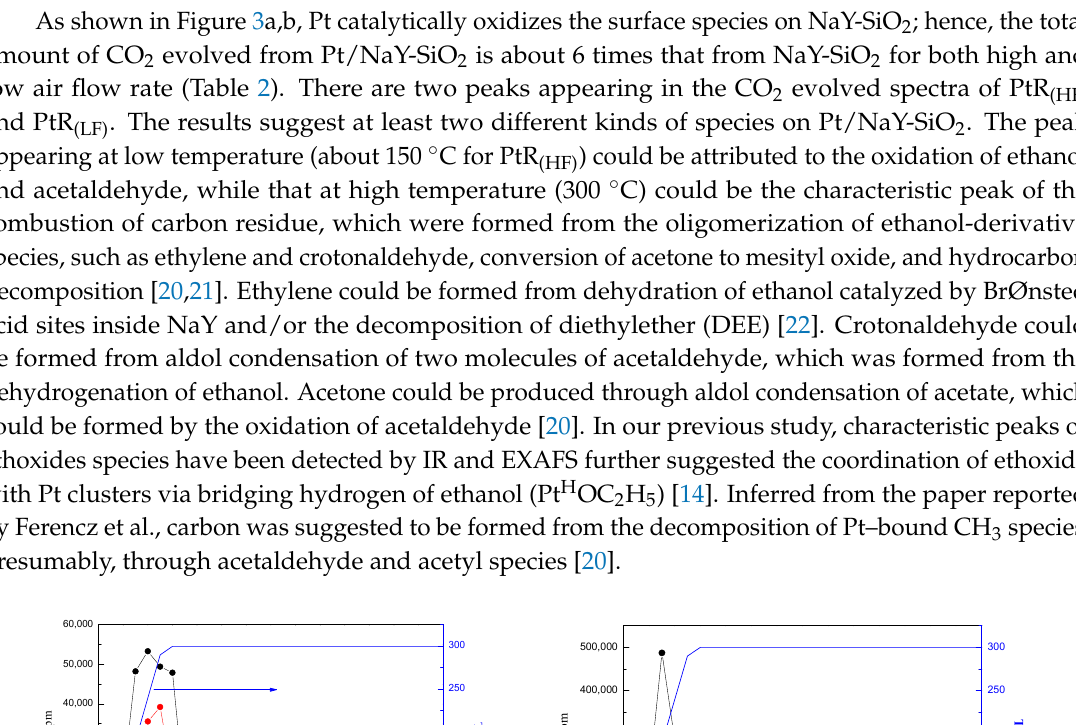
Figure 4. ( a ) Ethanol desorbed and species formed in temperature programmed regeneration of EtOH-laden NaY-SiO 2 : ethanol desorbed at high flow rate (black • ), ethanol desorbed at low flow rate (red • ), DEE formed at high flow rate (black ▼ ), DEE formed at low flow rate (red ▼ ); acetaldehyde formed at high flow rate (black ■ ), acetaldehyde formed at low flow rate (red ■ ). ( b ) Ethanol desorbed and species formed in temperature programmed regeneration of EtOH-laden Pt/NaY-SiO 2 : ethanol desorbed at high flow rate (black • ), ethanol desorbed at low flow rate (red • ), acetaldehyde formed at high flow rate (black ■ ), acetaldehyde formed at low flow rate (red ■ ), DEE formed at high flow rate (black ▼ ), DEE formed at low flow rate (red ▼ ).